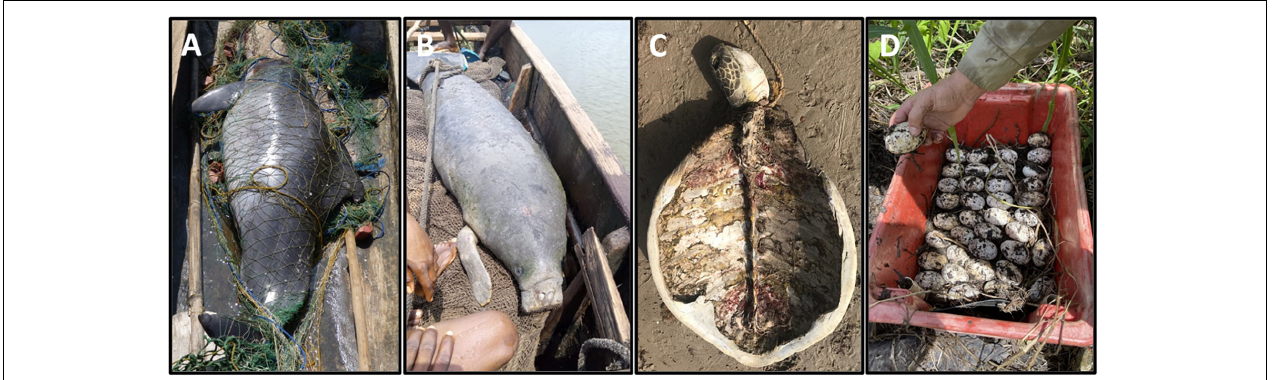
FIGURE 1 | Migratory megafauna used for aquatic wild meat, including: (A) Atlantic humpback dolphin ( Sousa teuszii ), Conkouati-Douli National Park, Republic of the Congo; (B) African Manatee ( Trichechus senegalensis ), Lagos Lagoon, Nigeria; (C) Green turtle ( Chelonia mydas ), Joal, Senegal; and (D) Saltwater crocodile ( Crocodylus porosus ) egg collection, Northern Territory, Australia. Photo credits: Tim Collins (A) , Christogonus Uzoma Ejimadu (B) , Pearson McGovern, African Aquatic Conservation Fund (C) , and Yusuke Fukuda (D) .